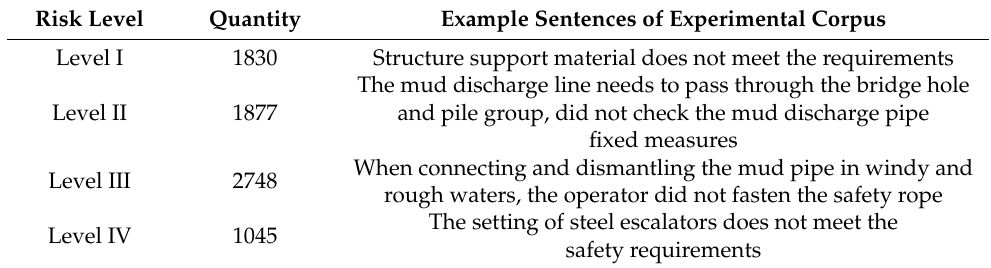
Table 3. Risk level classification and